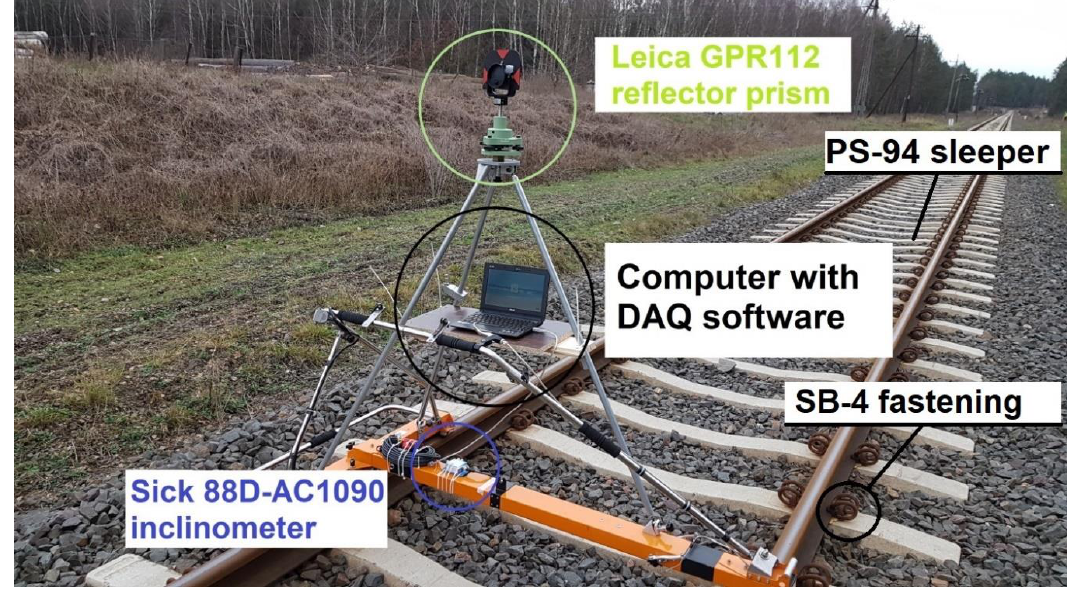
Figure 4. Measuring set number two for tacheometric measurement.